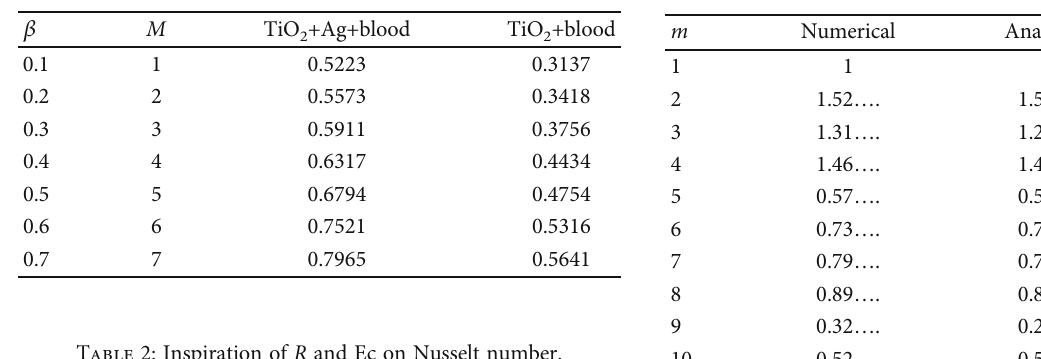
Table 5: Comparison for f ′ ð η Þ . And publish